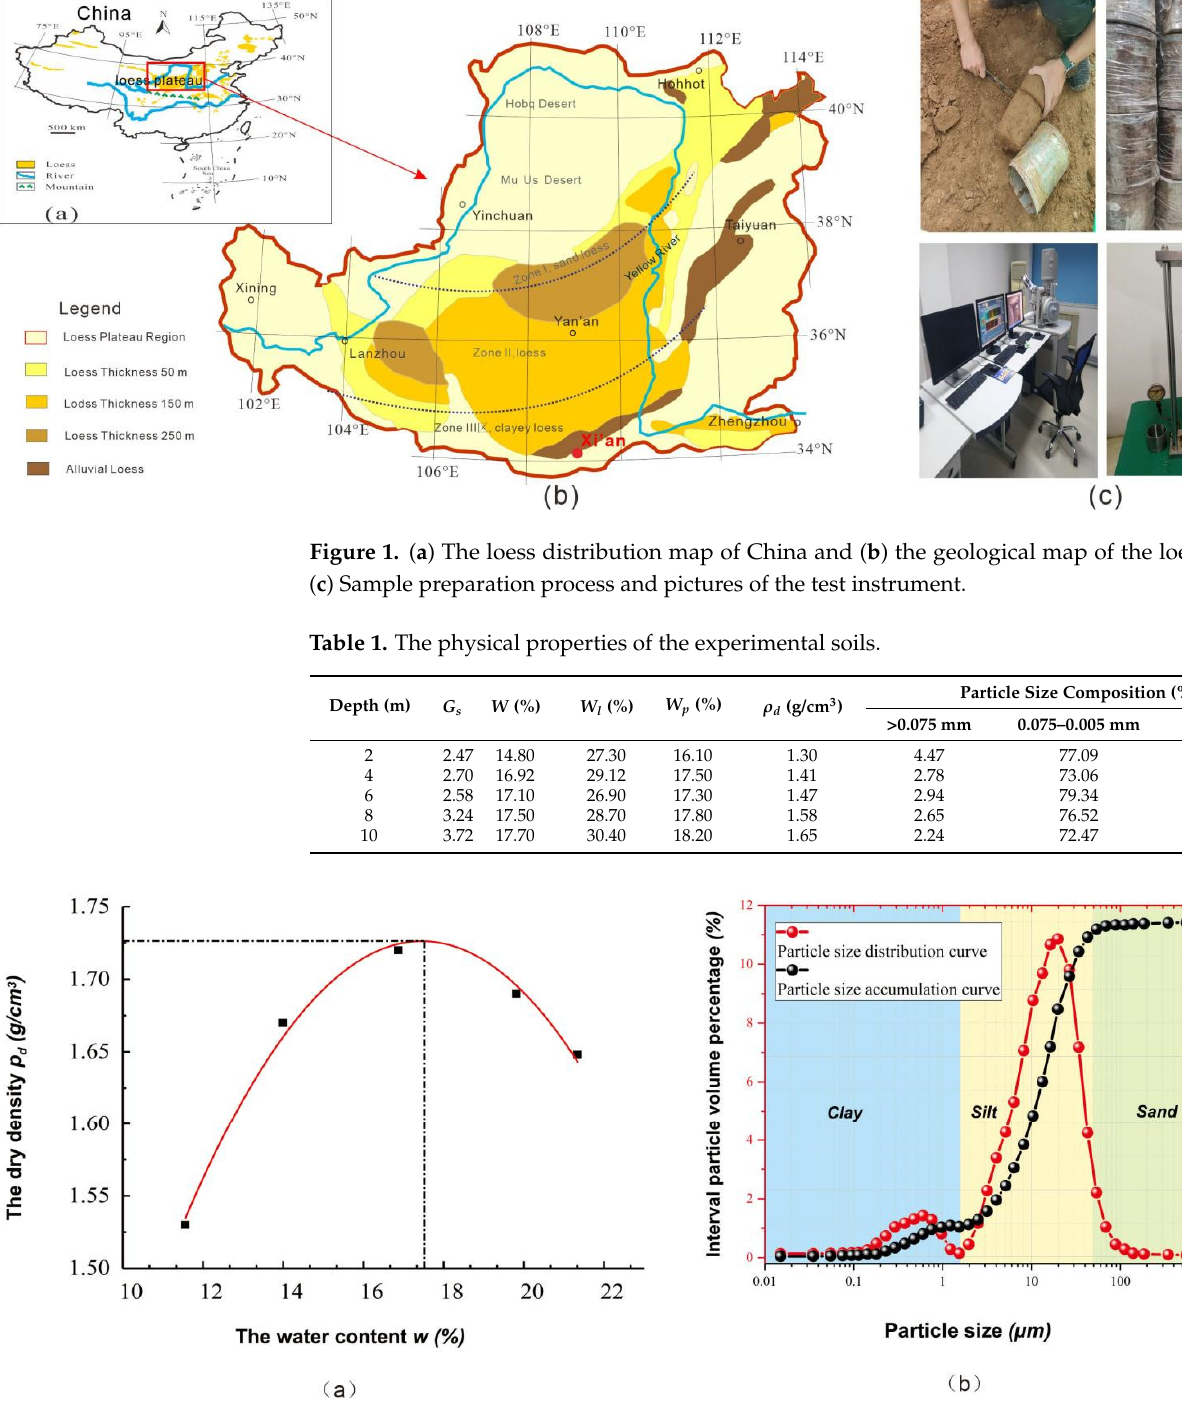
Figure 2. ( a ) The compaction curve of Malan loess in the Chanhe section. ( b ) The particle size distribution curve and particle size grading accumulation curve.